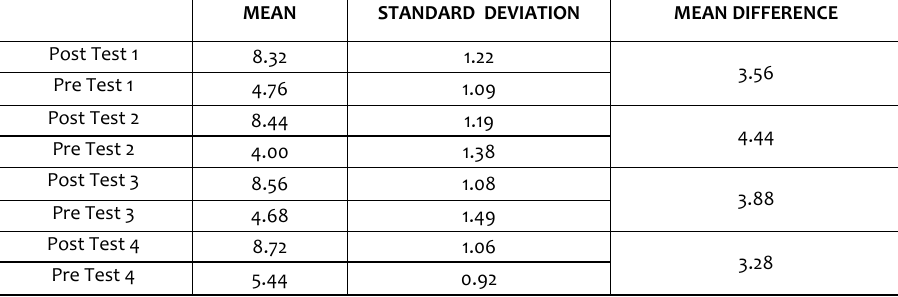
Table 1: Respondents’Pre-test and Post-test